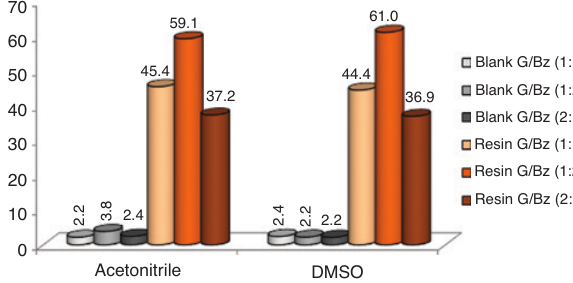
Figure 5: Glycerol yield (%) comparison ratios versus organic solvents. Errors deviation in